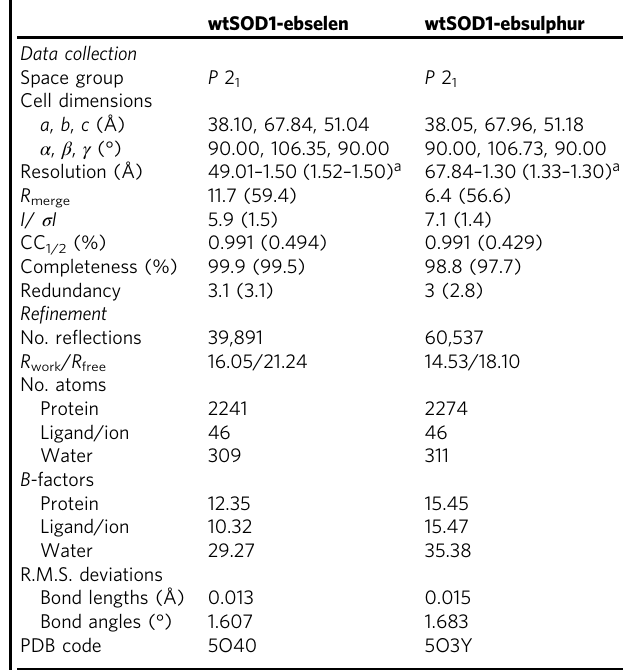
Table 1 Crystallographic statistics for SOD1-bound ebselen and ebsulphur